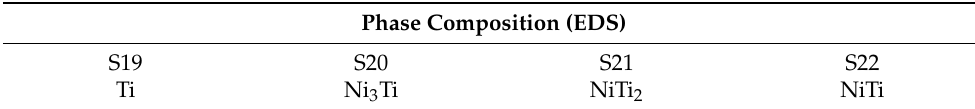
Figure 11. Micrographies of 3D objects from filament D (addition of 5 wt.% TiH 2 and Ni). ( a ) after sintering (SEM), ( b ) selected zones for evaluation of Ni:Ti ratio (S19, S20, S21 and S22) by SEM/EDS. Similar to sintered 3D objects from filaments with TiH 2 lower than 5 wt.%, microgra- phies and x-ray diffractograms from 3D objects with composition D (Ni in excess, other than the pristine one) show again the formation of a white phase identified as Ni 3 Ti. Despite the addition of Ni, Figure 11 and Table 9 show the occurrence of a “new phase” almost depleted of Ni, suggesting the presence of Ti without any reaction with other metal present. However, there are no discernible Ti peaks in the x-ray diffractogram (Figure 12). Table 9. Three-dimensional object phases from filament D after sintering (Spectra 19, 20, 21, and 22 in Figure 11b).